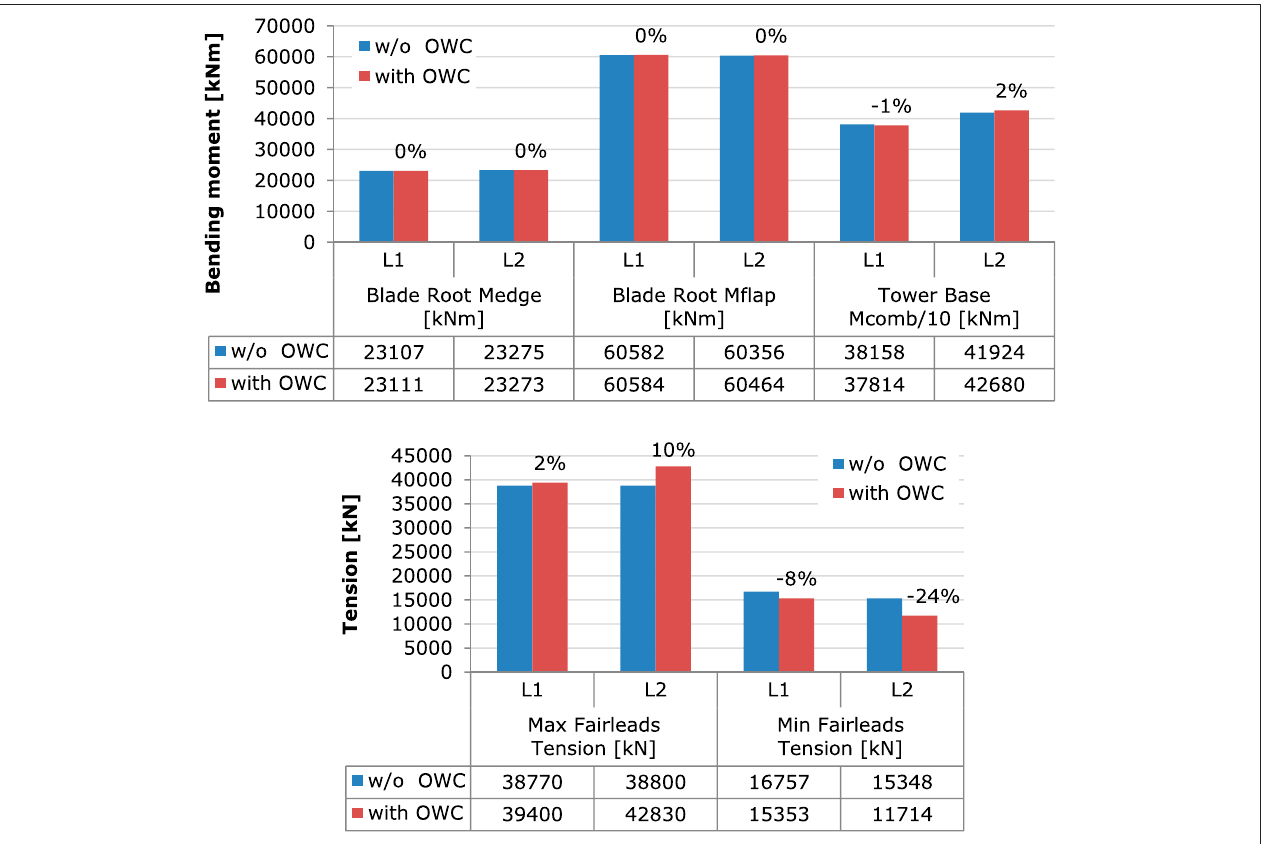
FIGURE16| AssessmentoftheOWC effect on loadsfrom DLC1.3. Ultimate bladeroot edgewise and fl apwisemoments and towerbase combined moment(top) and maximum and minimum ultimate mooring line tension at fairleads (bottom) at L1 and L2, with and without (w/o) the OWC.